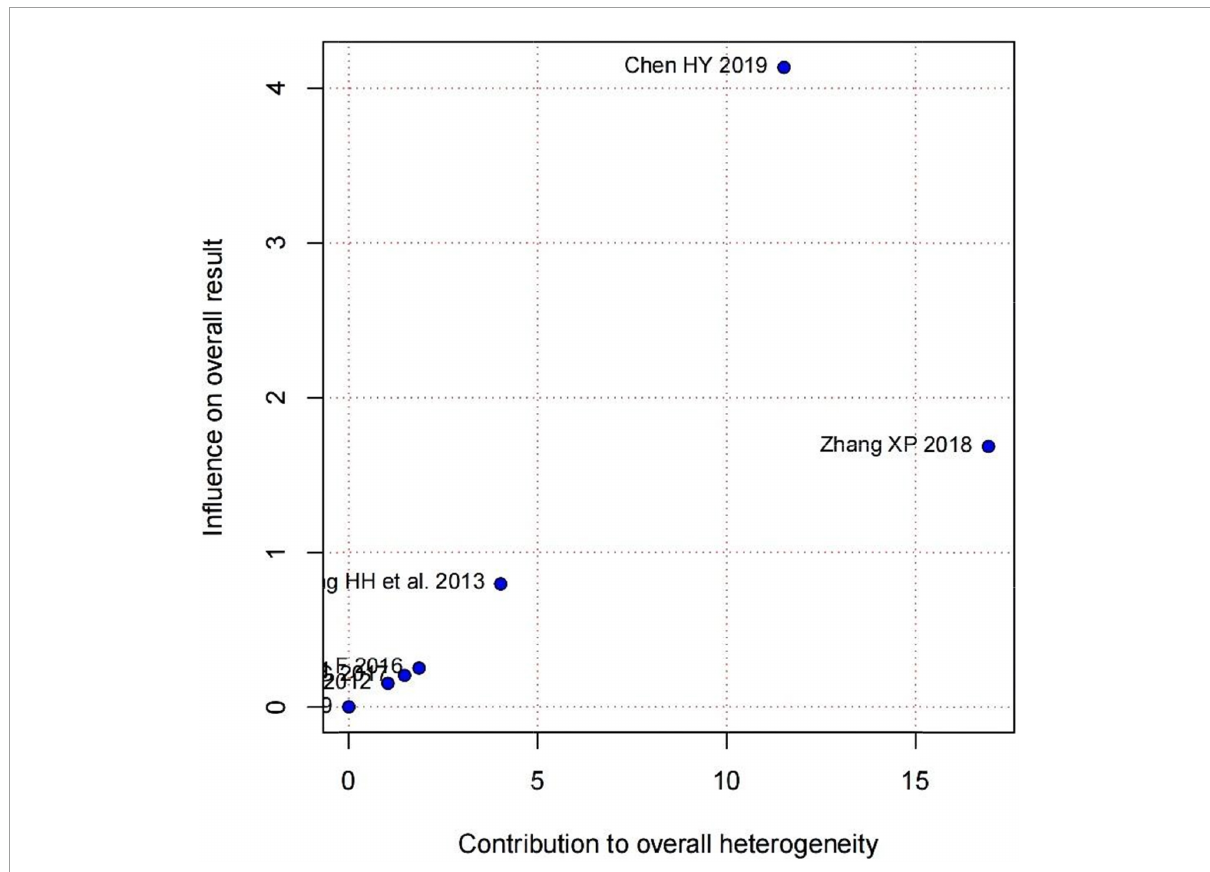
FIGURE6 Baujat plot demonstrating each study’s contribution to overall heterogeneity from seven studies that reported premature junctional beats after treatment (X-axis represents Cochran Q-test value representing the study’s contribution to the overall heterogeneity).